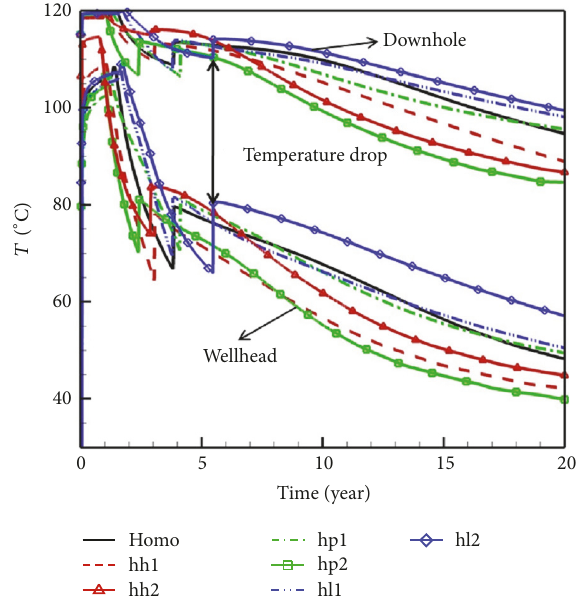
Figure 7: Temperature variation of output